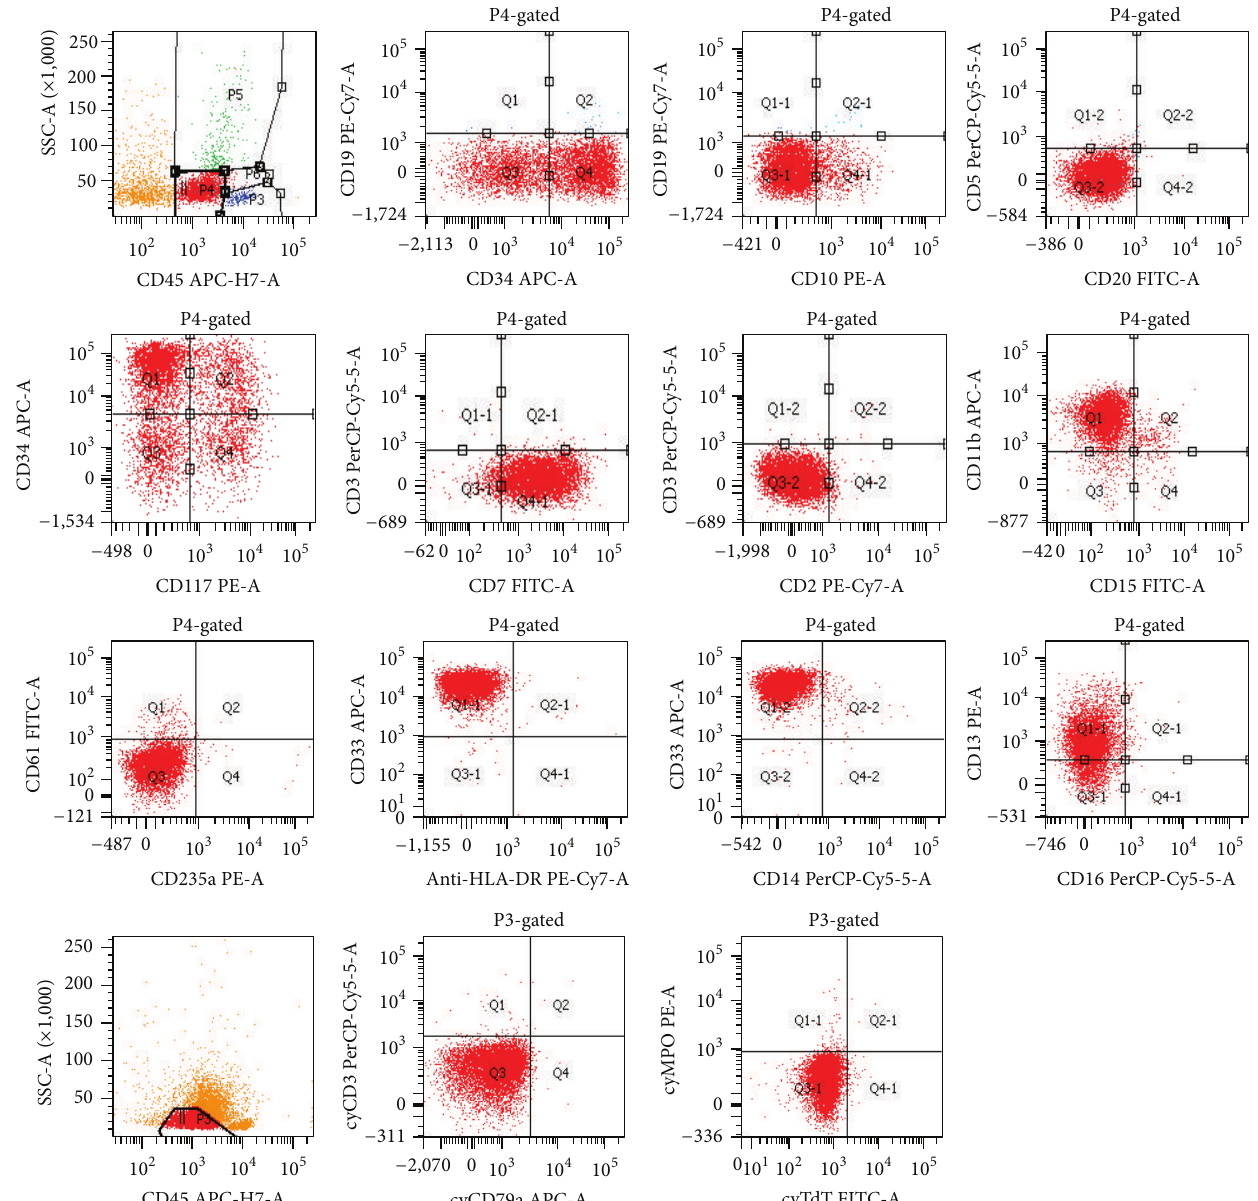
Figure 4: Flow cytometric immunophenotypic analysis of vitreous fluid: blast gate (P4 gate in the top line) represents the dim CD45+ cells with low side light scatter (SSC). Blast gate (P3 gate in the bottom line) represents the same population of blasts analyzed for cytoplasmic markers in a separate tube. The distinct cluster of blasts (red color population) exhibit the following immunophenotypic characteristics: positive for CD34, CD117, CD7, CD11b, CD13 (dim), and CD33; negative for CD19, CD10, CD20, CD3, CD5, CD15, CD16, CD61, CD235a, HLA-DR, CD14, cytoplasmic CD3, cytoplasmic CD79a, cytoplasmic MPO, and cytoplasmic TdT.